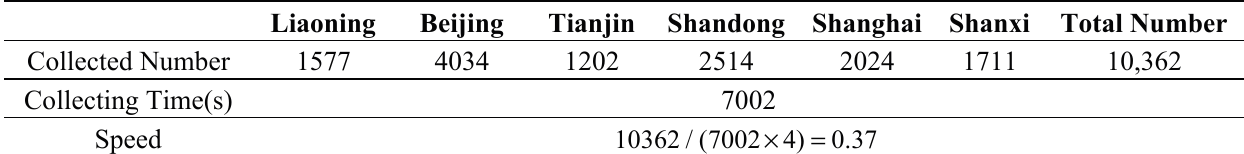
Table 4. Collection results and efficiency of the extra experiment.